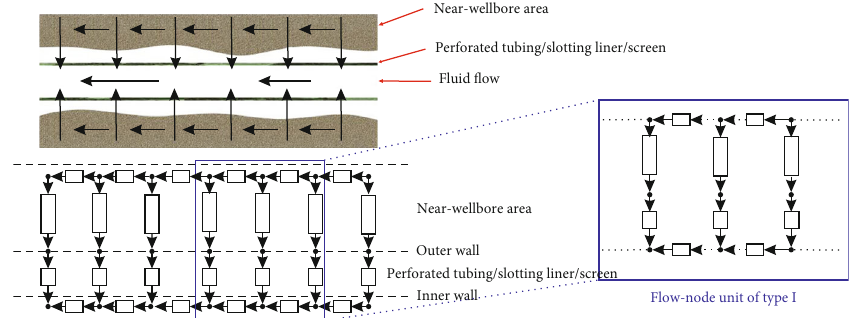
Figure 1: Schematic diagram of completion nodes without